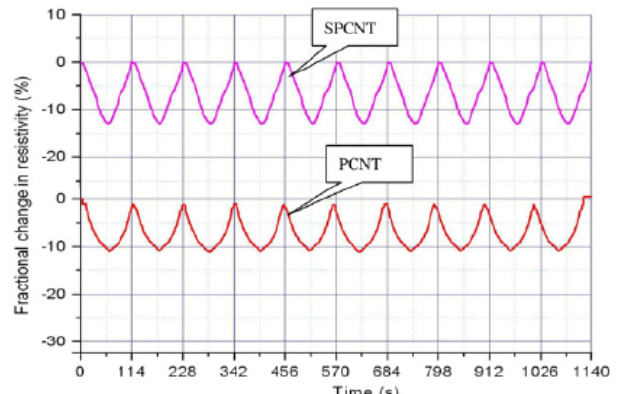
Figure 16: Fractional change in resistivity in function of time under cyclic compressive loading (0-15 kN) on 40×40×160 mm 3 prisms (PCNT: untreated CNTs, SPCNT: treated CNTs, 0.5 wt%/ cement)